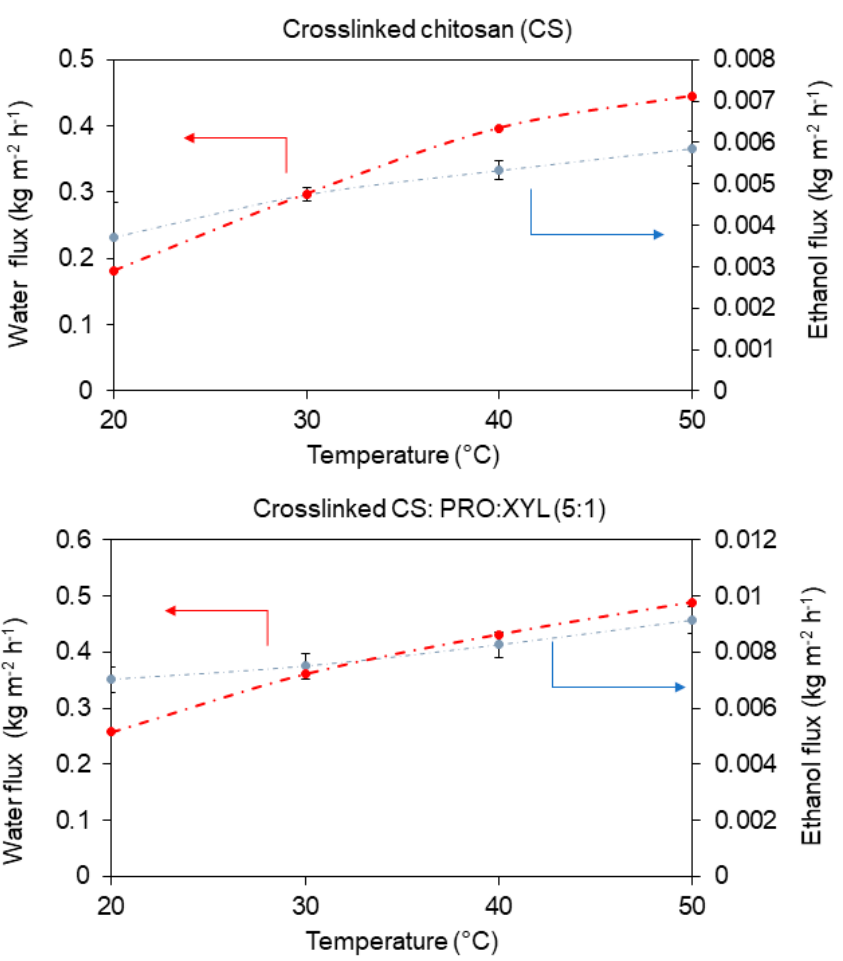
Figure 7. Water and ethanol partial fluxes as a function of operating temperature (10:90 wt.% water- ethanol). The curves are only guiding the eye.